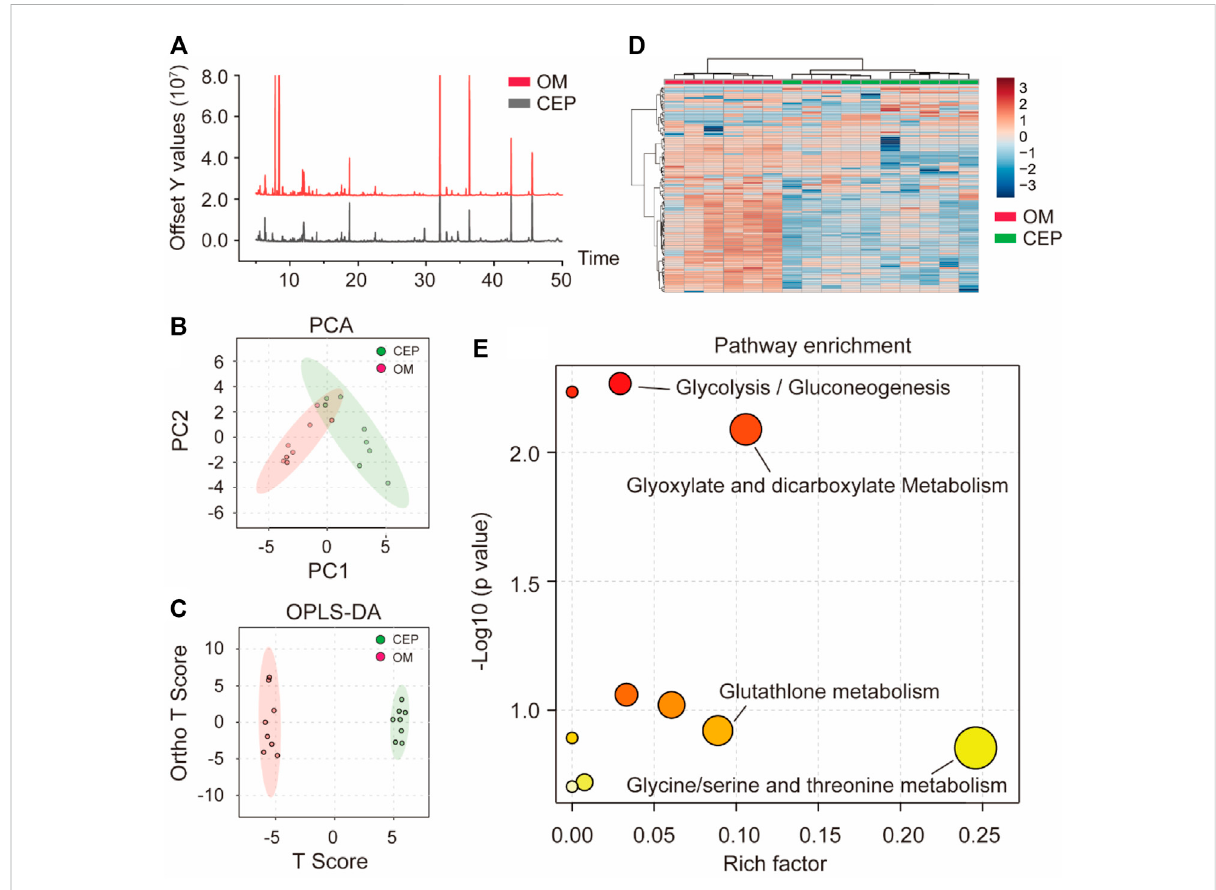
FIGURE 3 Metabolomic analysis of VICs with or without CEP treatment under the OM induction. (A) Total ion fl ow diagram; (B) PCA classi fi cation; (C) OPLS-DA classi fi cation; (D) the heat map analysis; (E) pathway enrichment analysis based on differential metabolites (VIP >